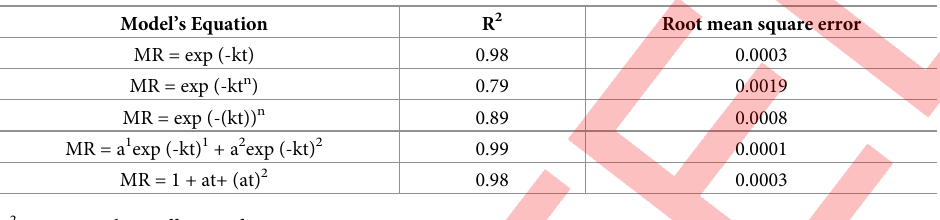
R 2 represents the coefficient of regression.